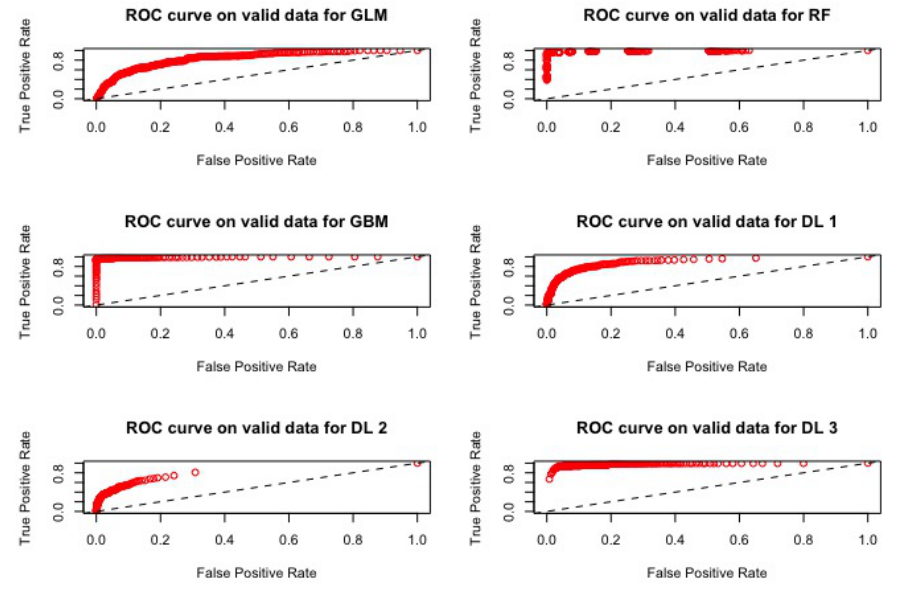
Figure 1. ROC curves for the models M1, M2, M3, D1, D2 and D3 using 181 variables using the validation set.